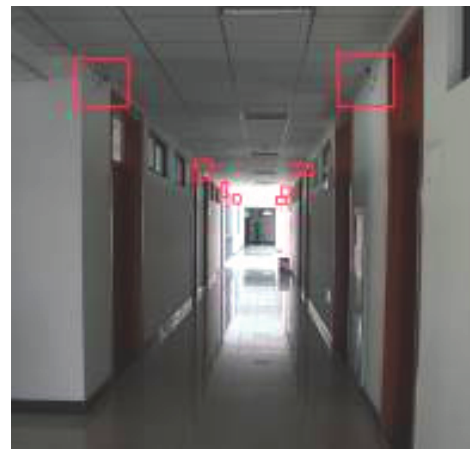
Figure 16. Indoor positioning test field.